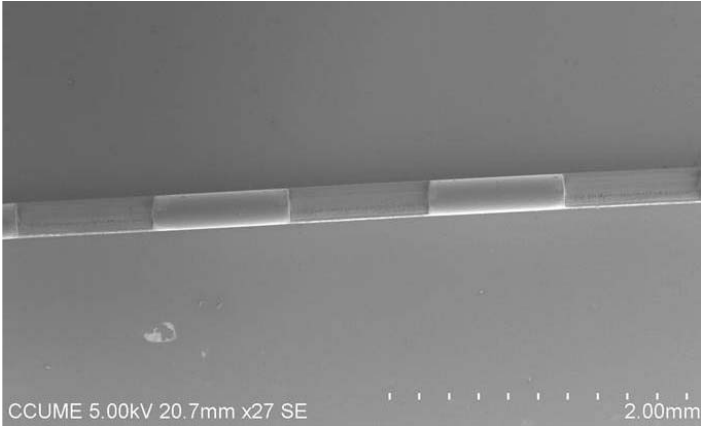
Figure 3 . SEM image of a multi-D-shaped optical fiber.